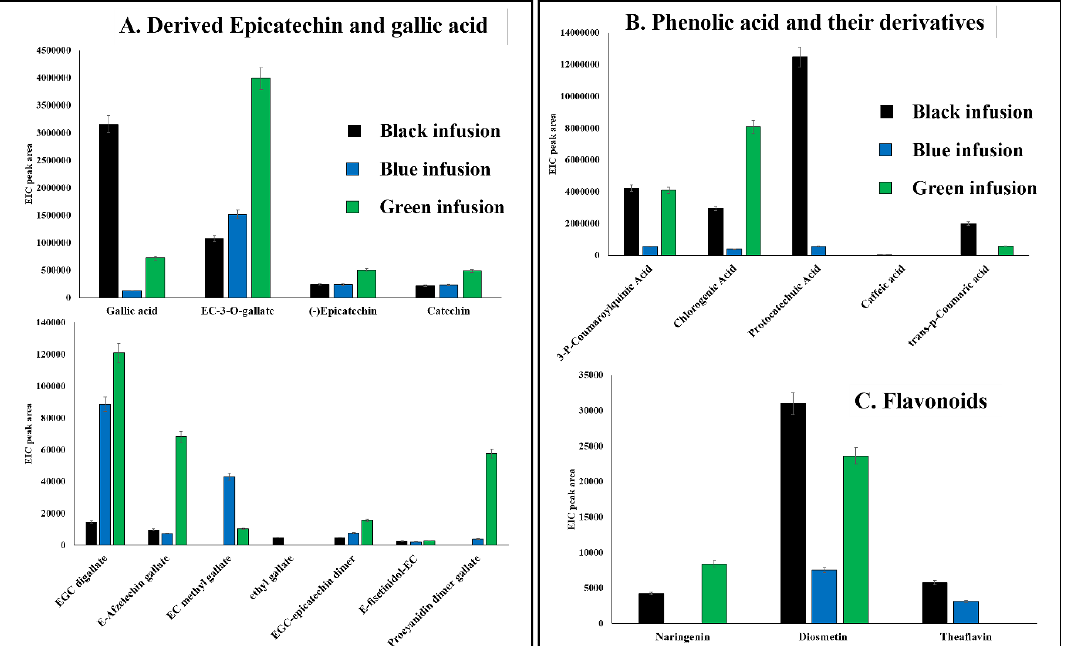
Figure 2. Histogram comparison of all polyphenols from tea infusion samples, i.e., black, oolong, and green teas grouped on the basis of its derivation form epicatechin/gallic acid ( A ), quinic acid ( B ), benzoic acid, and its derivatives ( C ) flavonoids. EC = epicathecin; EGC = epigallocatechin. Among glucoside derivatives, rutin was detected at concentration of 60 µg/g in black tea,